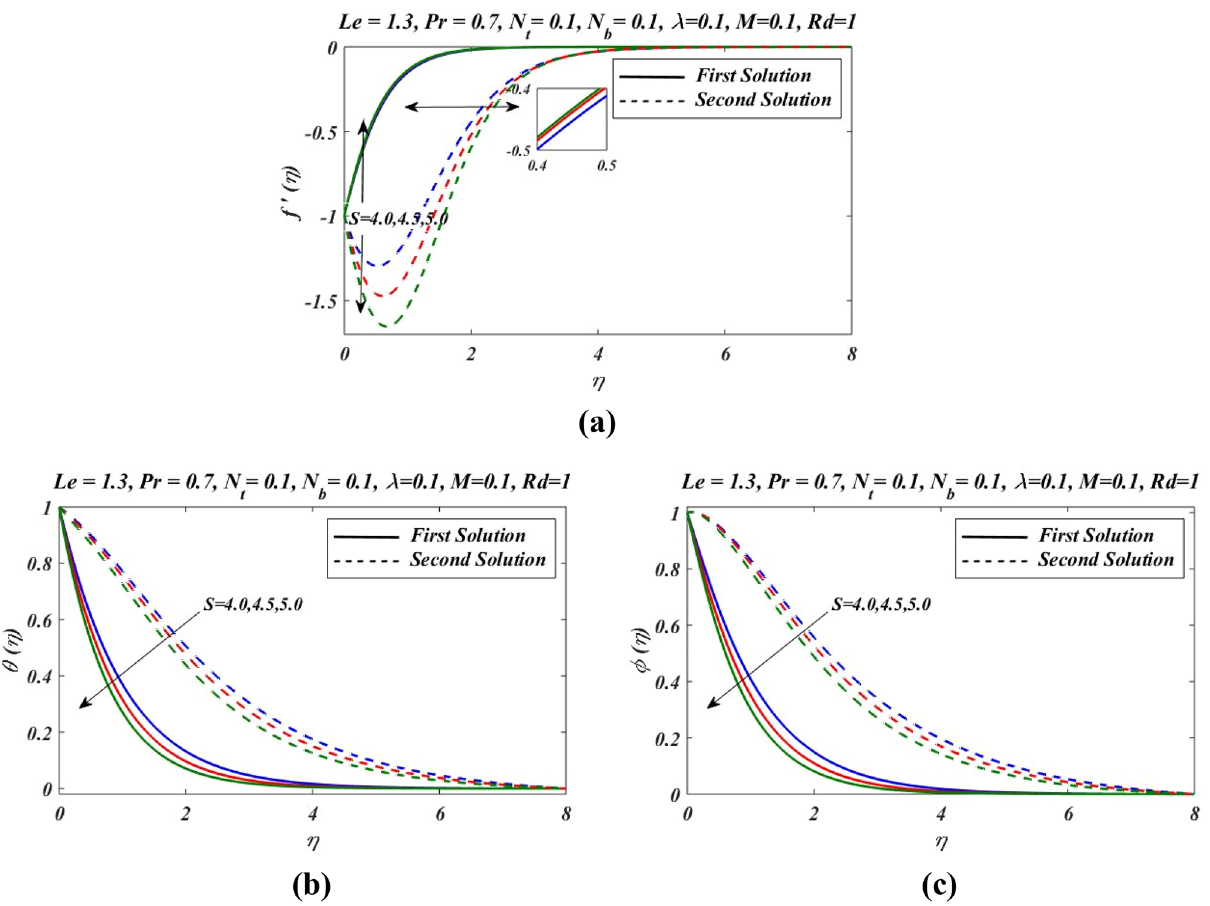
Figure 2. Outcomes of S on ( a ) velocity, ( b ) temperature and ( c ) nanoparticles volume diffusion coefficient. Figure 6 demonstrate effects of different values of Hartmann number M on different values of f ′ (η) , θ(η) and φ(η) . In Fig. 6a reveals that by increasing Hartmann number M , the velocity f ′ (η) increases and reduces in first and second zones, respectively. Figure 6b indicates that by increasing Hartmann number M ,